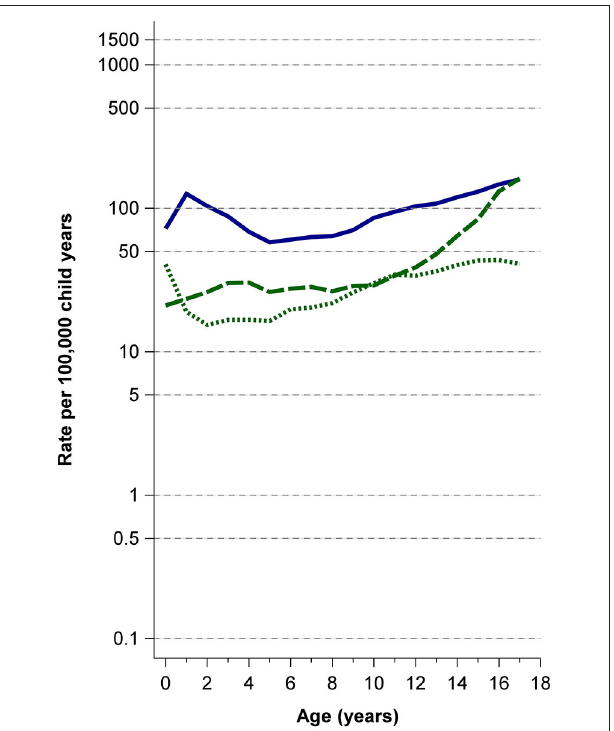
FIGURE 2 | Rates of loss of consciousness and imaging. Solid blue line : loss of consciousness; long-dashed green line : cranial computed tomography; short-dashed green line : cranial magnetic resonance